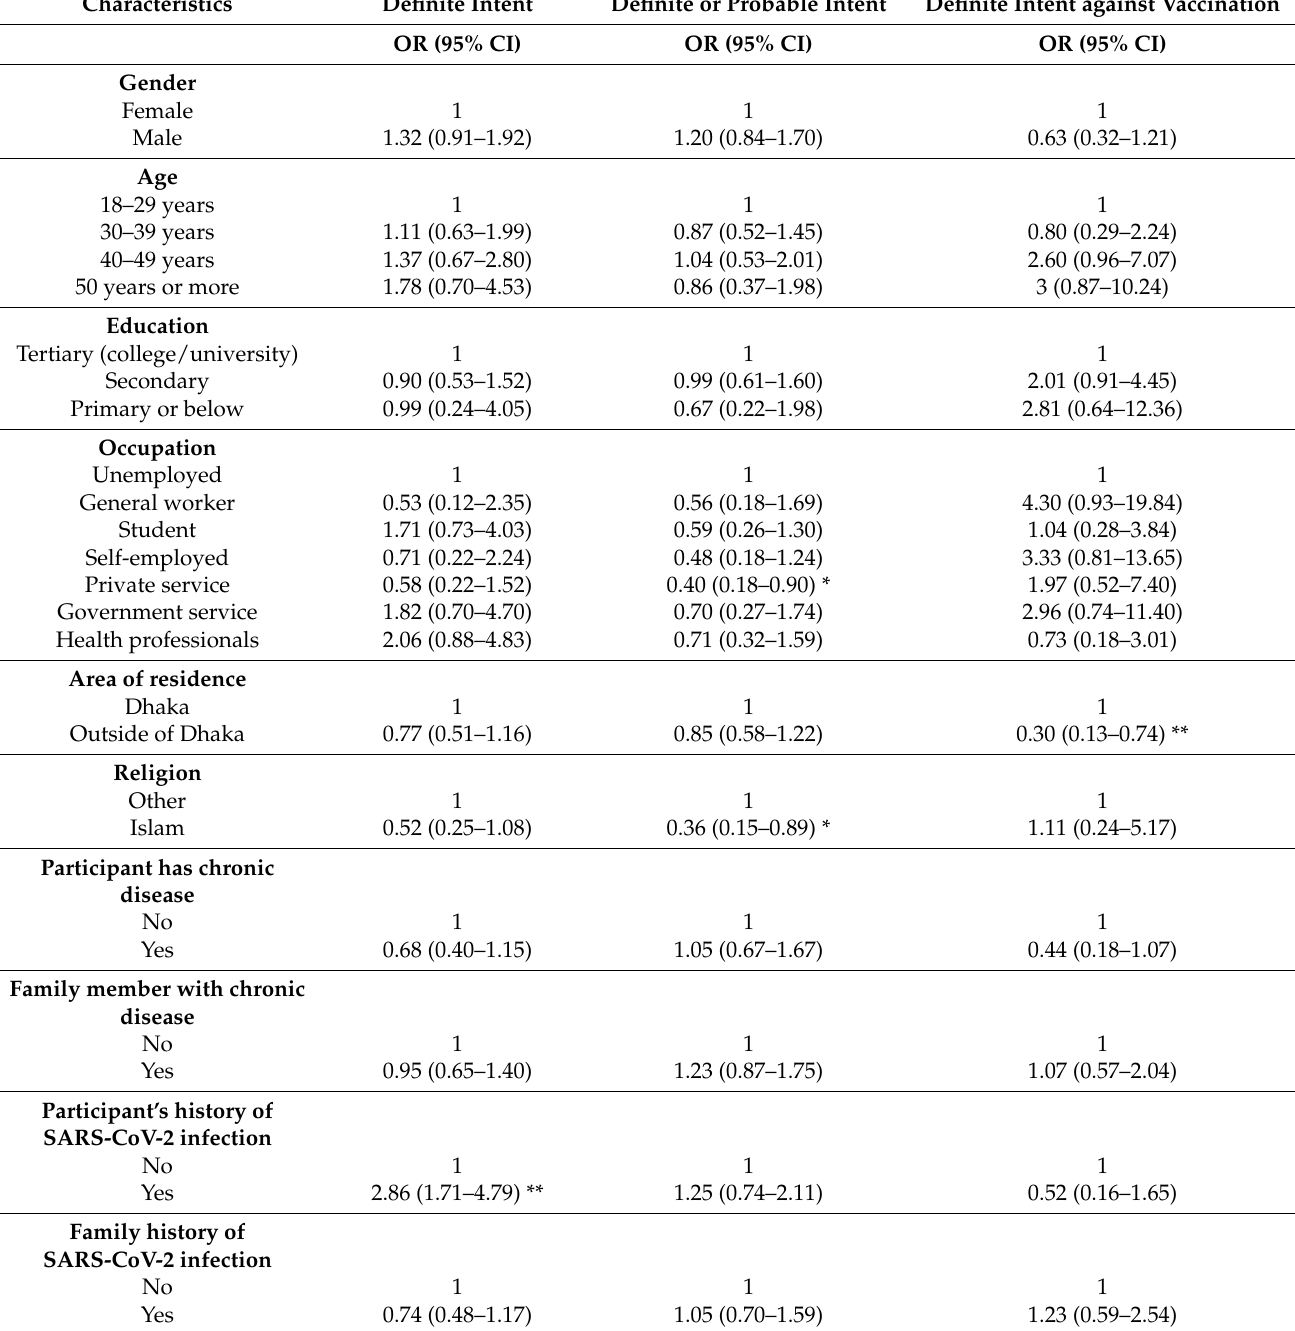
Table 2. Sociodemographic predictors of SARS-CoV-2 vaccination intent in Bangladesh, multivariable logistic regres- sion